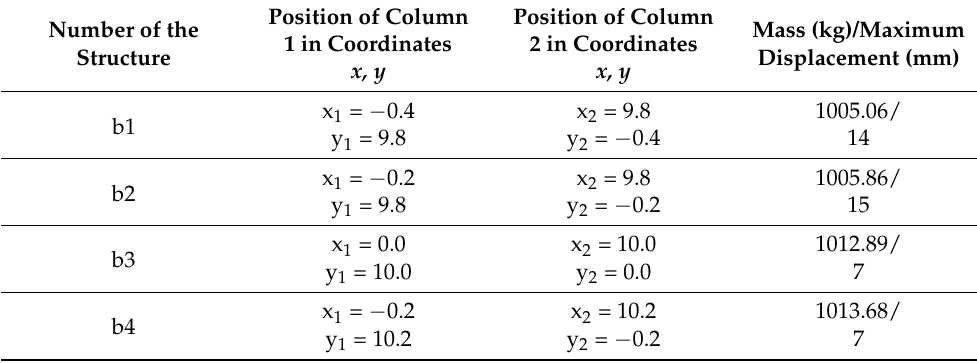
Table 2. The simulation results for the hyperbolic paraboloid structure with a grid pattern of type b (the grid split along longer